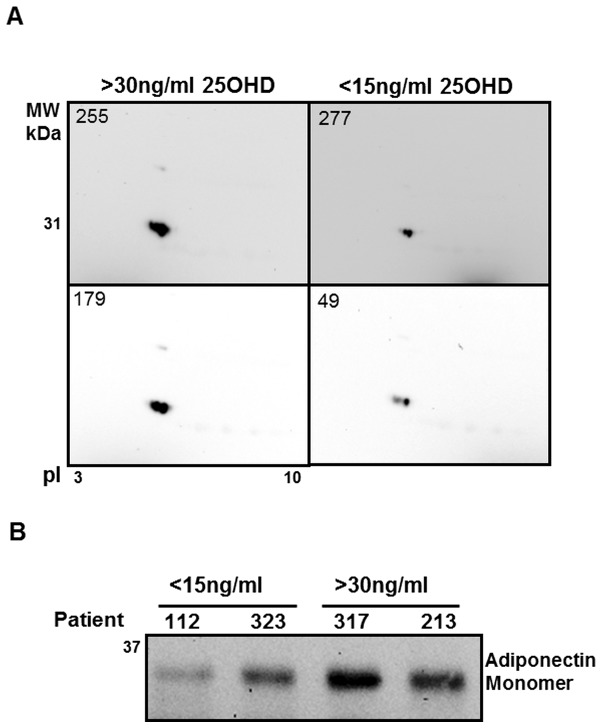
WIB of proteomic analyses and plasma samples confirms that total adiponectin is decreased in VD deficient pediatric obese subjects (VDD) when compared to pediatric obese with normal VD levels (NVD).
A. A WIB of 2D-electrophoretic analyses was performed in VDD (n = 10) and NVD (n = 10) subjects using anti-adiponectin antibody. B. A WIB analysis under reduced conditions of total adiponectin in the plasma of representative VDD (<15 ng/ml) and NVD (>30 ng/ml) subjects.